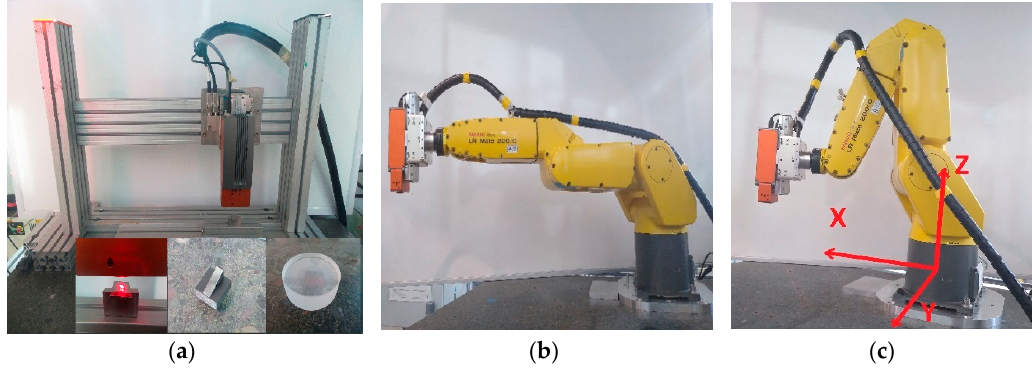
Figure 1. Measurement setup: Heliotis was mounted on a stable, rigid H-frame ( a ) or on the robot arm in a fully extended pose ( b ) or a compact pose ( c ). Insets on ( a ) show typical artefacts used: from right to left, an optical flat glass surface, a tilted metal flat (slip-gauge) surface and a step-artefact realized by wringing two slip-gauges of different thickness onto a third